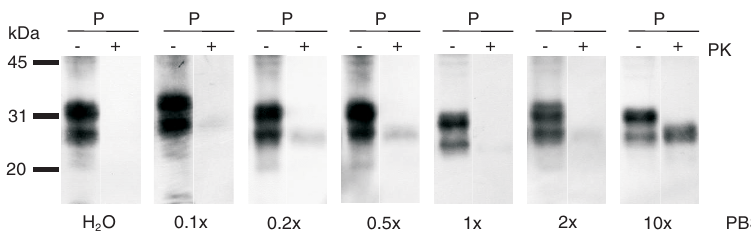
Figure 3. Influence of ionic strength on the resistance of PrP Sc to proteinase K (PK) after pressure treatment. Immunoblot detection of native hamster PrP Sc with the 3F4 antibody. P = treated at 800 MPa, 60 º C, for 120 min in twice-distilled water (H 2 O) or in phosphate- buffered saline of different concentrations (0.1- to 10-fold concentrated). Samples were incubated with (+) or without (-)